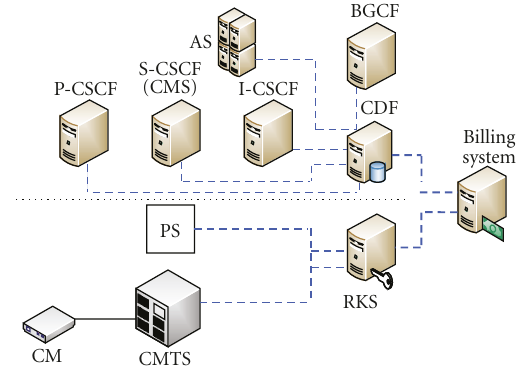
Figure 10: PacketCable 2.0 charging and billing